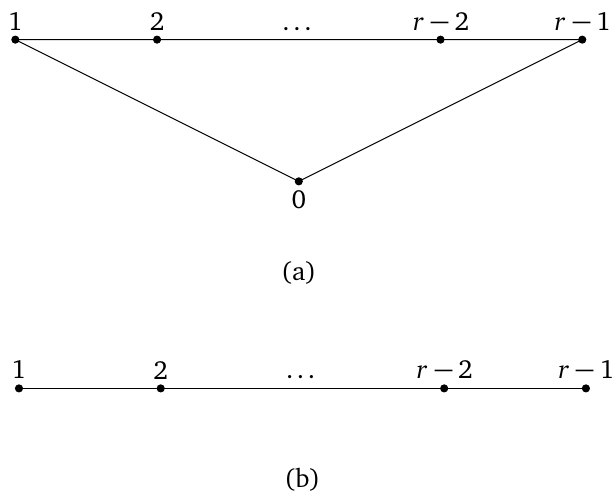
Figure 1: Adjacency graphs of the CSOS model (a) and the RSOS model